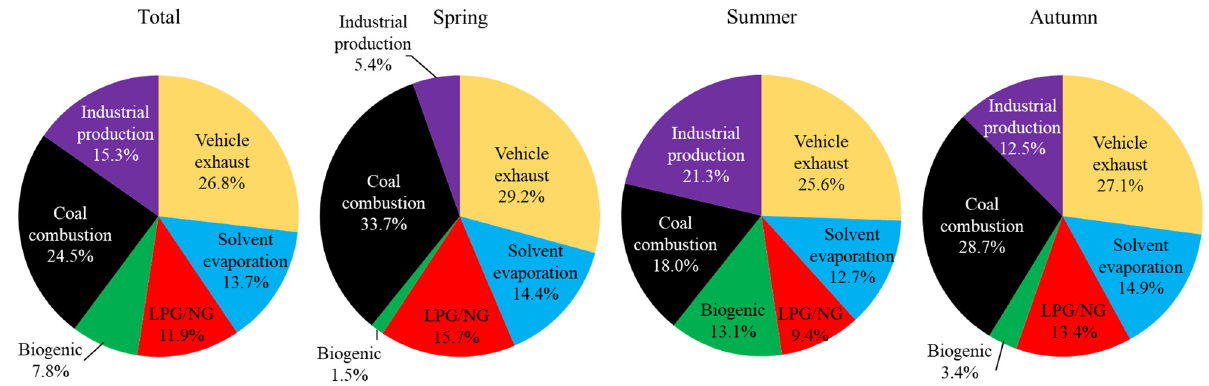
Figure 3. Contribution of each VOC source in Changzhi according to PCA during the total sampling time and various seasons.